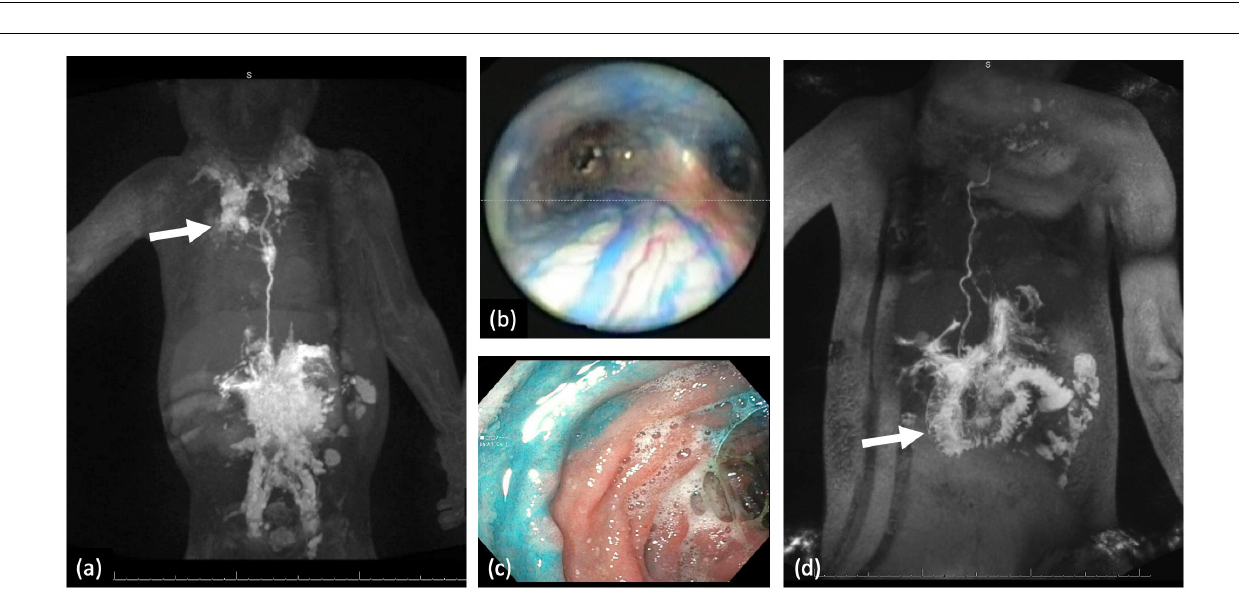
Frontiers in Pediatrics |